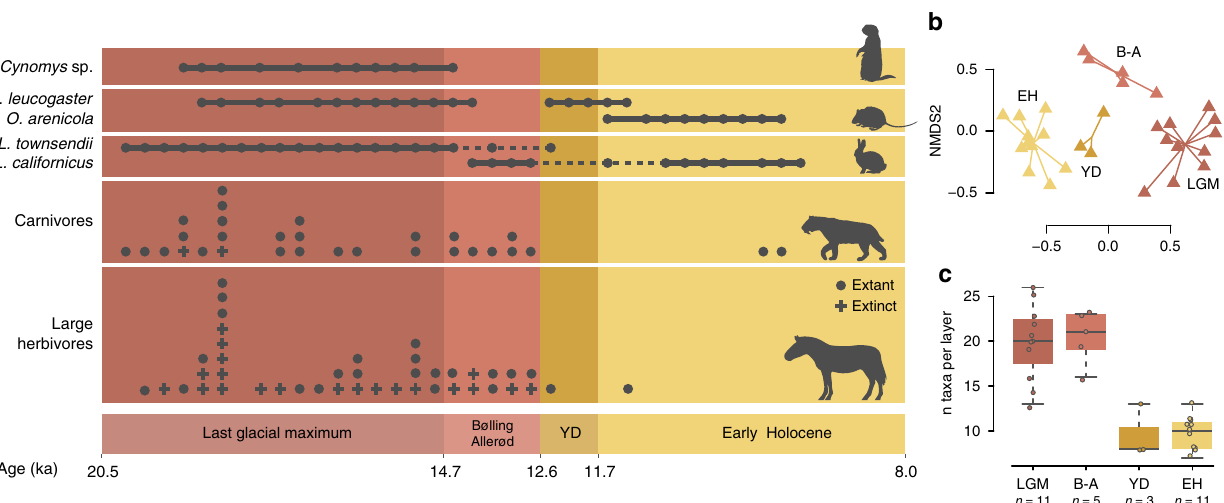
Fig. 3 Vertebrate diversity through time tracked via bulk-bone metabarcoding (BBM). a The lower two panels represent the number of different extinct and extant species of large herbivores (>30 kg) or carnivores, respectively, that were identi fi ed in each layer. The upper two panels indicate population replacement of selected indicator species. b Non-metric multidimensional scaling (NMDS) plot based on BBM results from samples excavated for this study (Supplementary Table 1). c Number of taxa detected per layer for samples excavated for this study illustrated with boxplots (centre line: median. Box limits: upper and lower quartiles. Whiskers extend to the extremes of the data, no data points were excluded). A total of 30 biologically independent samples from four time periods were compared: LGM ( n = 11), Bølling – Allerød ( n = 5), YD ( n = 3) and Early Holocene (n = 11). Source data are provided as a Source Data fi